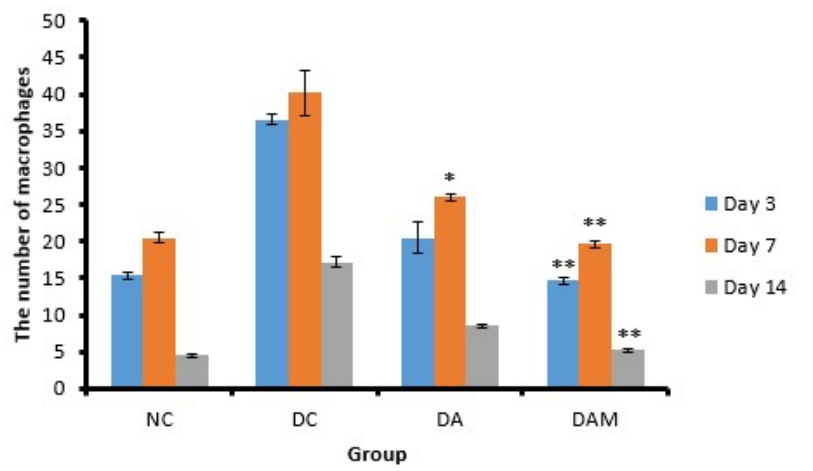
Figure 7. Number of macrophages at the three variation times. Notation on the graph shows the result of the statistical test ( α < 0.05). * and ** notation shows insignificant differences with NC but significant differences with DC. * = 0.01 ≤ α < 0.05; ** = α ≤ 0.01. NC: normal group; DA: alginate treatment group; DAM: alginate–mangosteen rind extract treatment group; and DC: diabetic group.